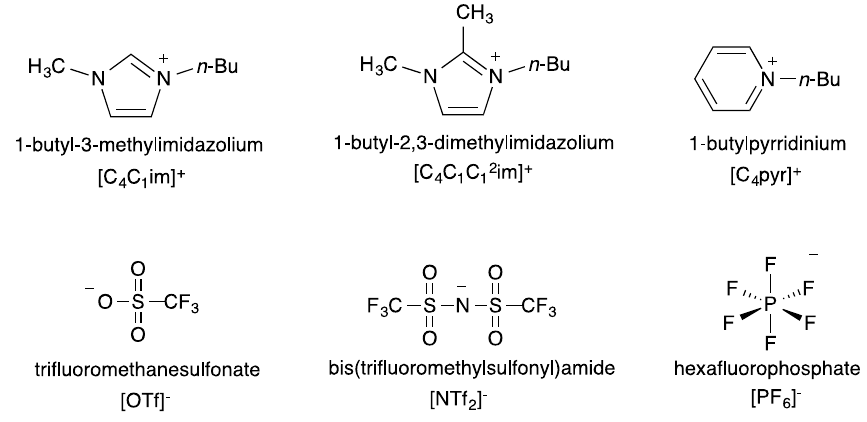
Figure 1. Structures and abbreviations of the cationic and anionic IL components chosen for this study.